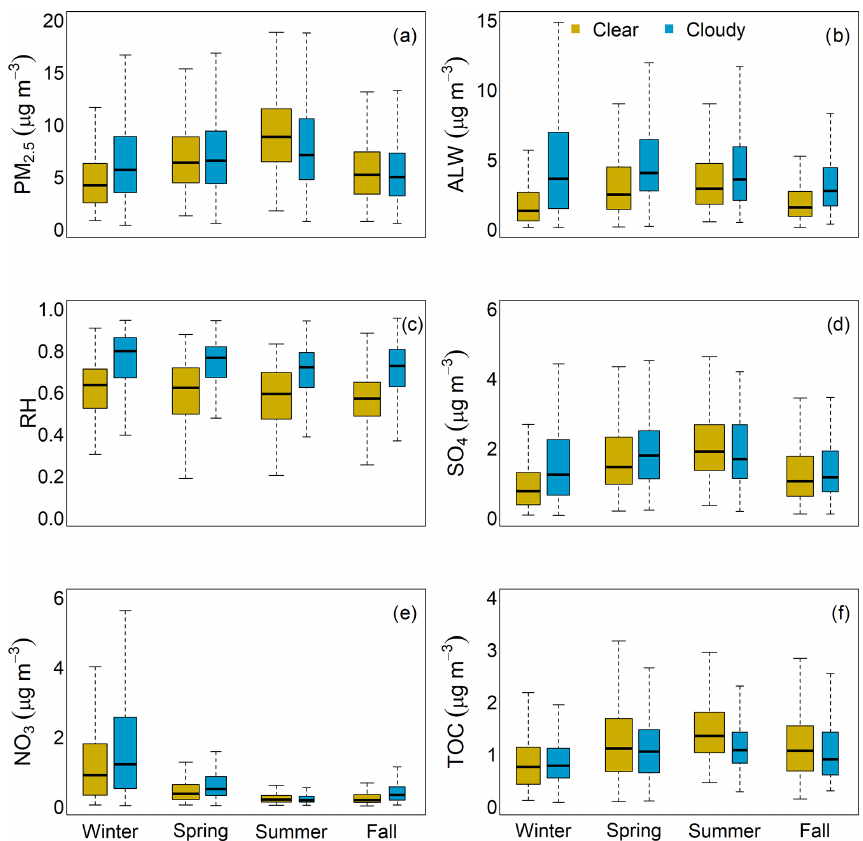
Figure 5. Distributions of (a) PM 2 . 5 , (b) ALW, (c) RH, (d) SO 4 , (e) NO 3 , and (f) TOC mass concentrations in all seasons in the Mid-South. Yellow box plots indicate clear-sky times, and blue box plots indicate cloudy times. The width of the box plots is proportional to the number of observations in each. Note that potential outliers are not shown but are used in calculations. Table 1. Particle chemical constituent concentrations, meteorology, and growth factors during cloudy (Cl) and clear-sky (CS) times in the Mid-South.